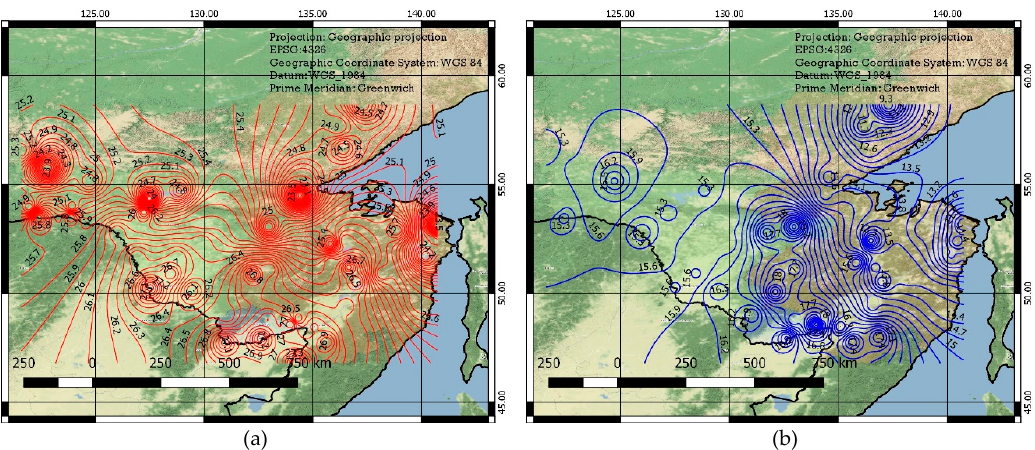
Figure 5. Isolines of the distribution of the maximum air temperature (a) and the sum of rainy days (b) according to the data of 50 stations of the Far East for July–August 1980–2009.